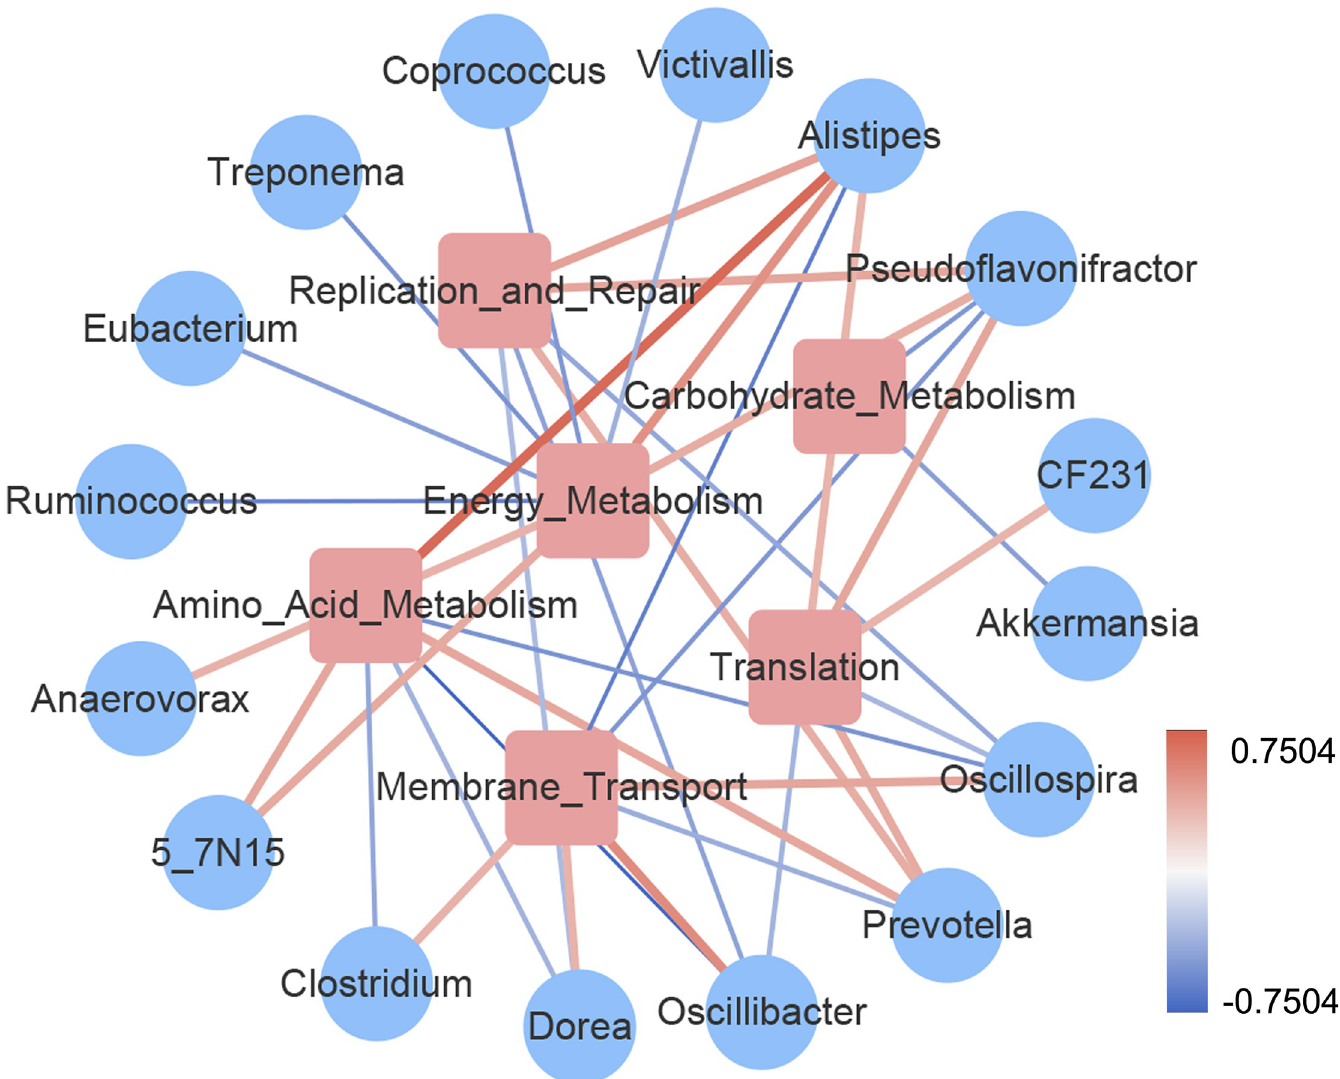
Fig 7. Correlation between genera and metabolic secondary